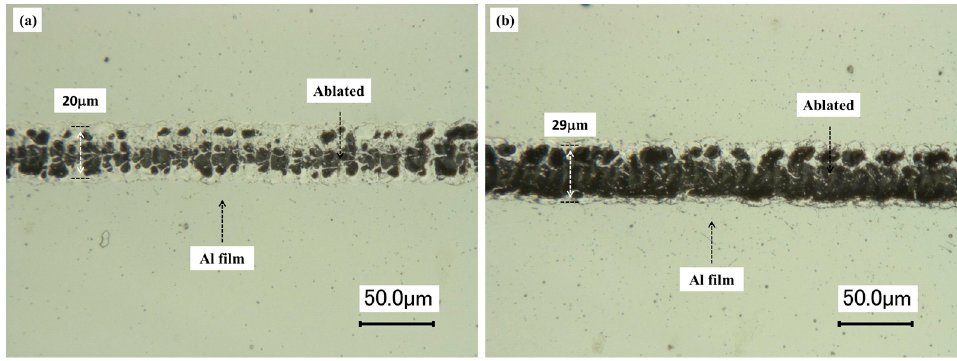
Figure 7. Optical images of straight line etched by nanosecond laser: ( a ) etching energy is 6.8 μ J , and ( b ) etching energy is 9.8 μ J .